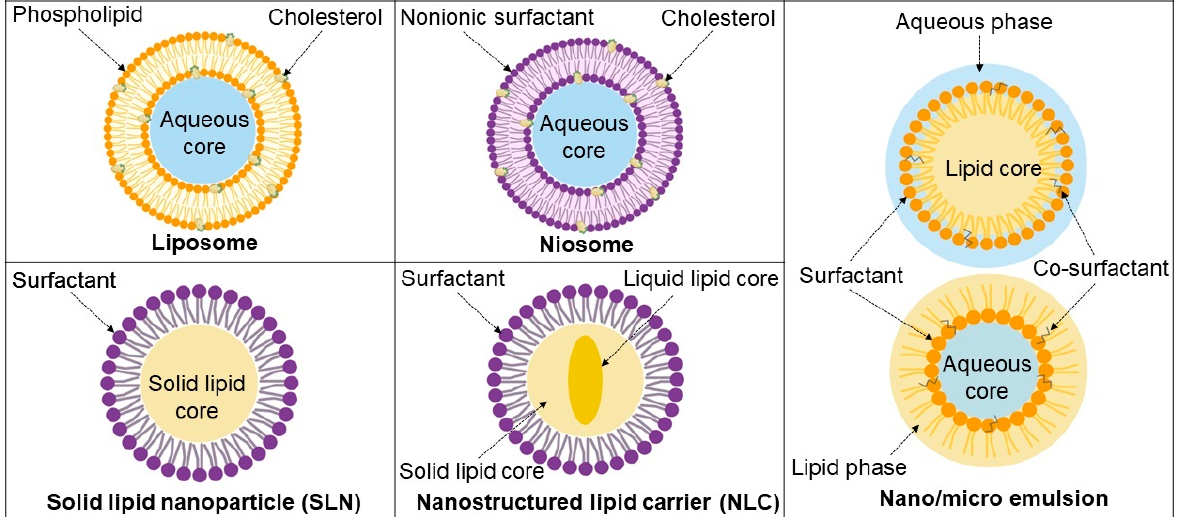
Figure 2. Schematic representation of lipid-based systems discussed herein.